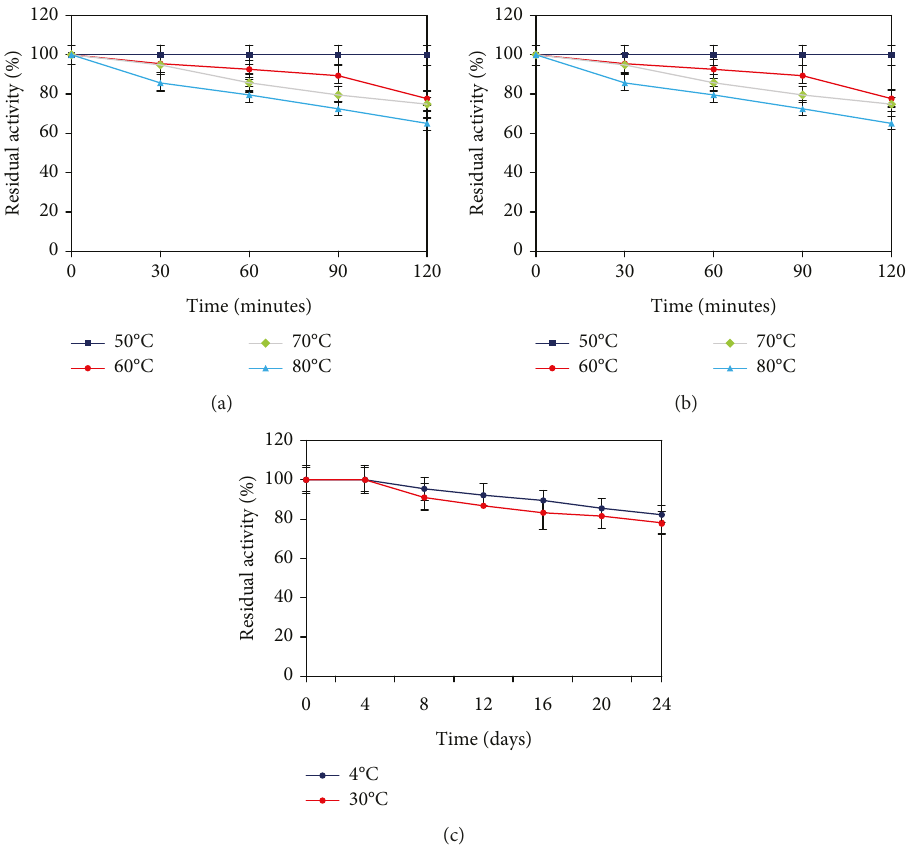
Figure 4: Stability studies of dextranase entrapped in alginate spheres: (a) thermal stability of soluble dextranase at di ff erent temperatures for di ff erent time intervals; (b) stability of entrapped dextranase at high temperature for varying time intervals; (c) storage stability of dextranase after entrapment at 4 ° C and 30 ° C. All values are shown as mean of three independent experiments ( n = 3